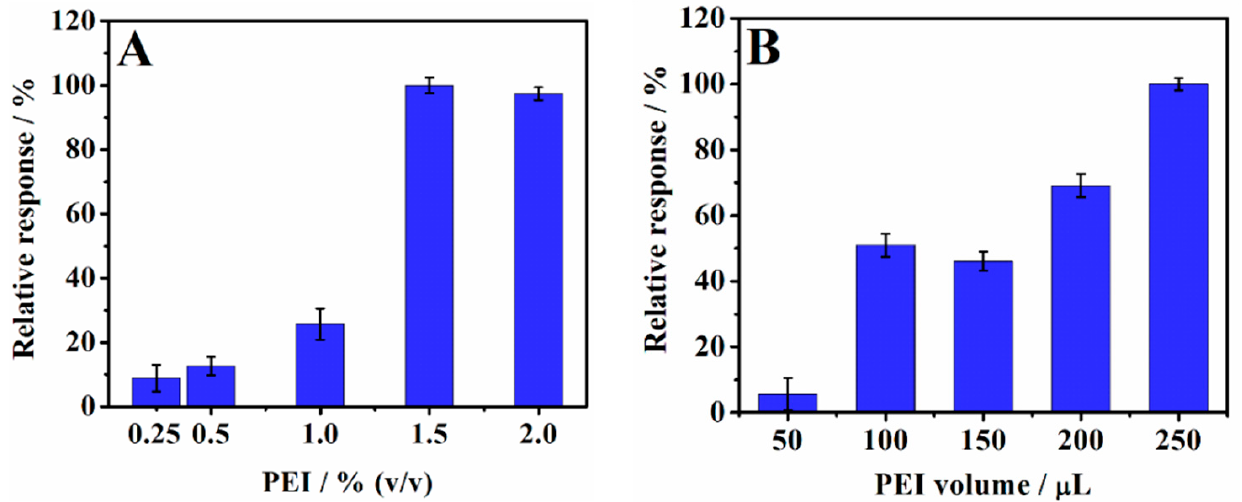
Figure 1. ( A ) Study of the effect of the percentage of PEI solution and ( B ) PEI solution volume on the relative response of the PEI/CPE to caffeic acid ( n = 3).